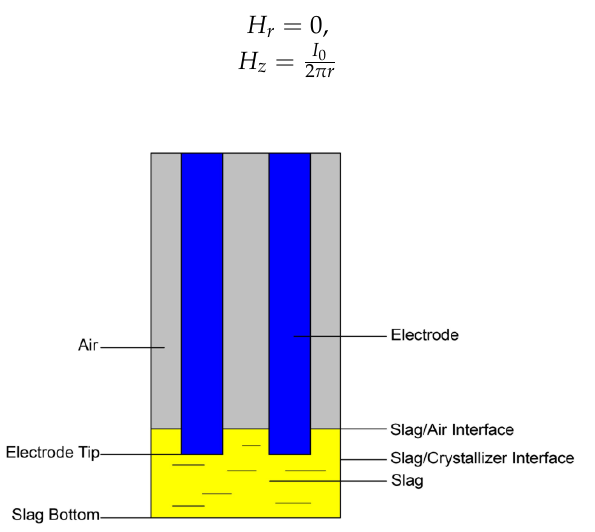
Figure 2. Physical concept of the electroslag remelting with two series-connected electrodes (TSCE- ESR).